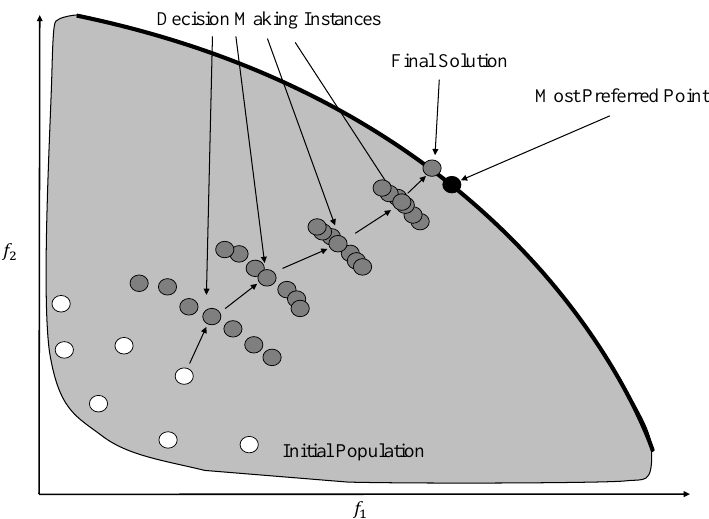
Figure 7. Progressive interaction during the